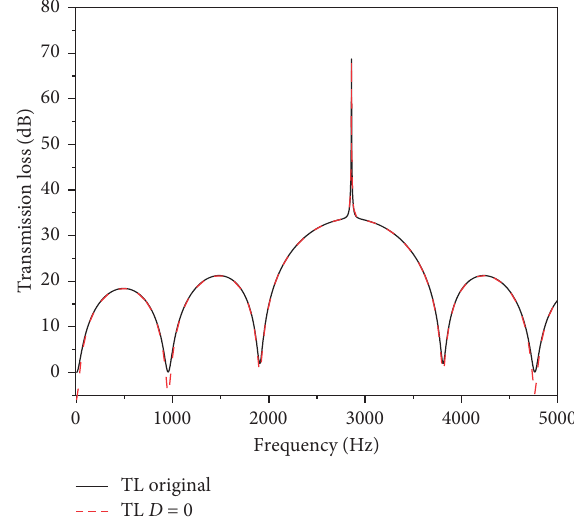
Figure 4: Quadrupole parameter analysis of the side outlet muffler ( B � 0).